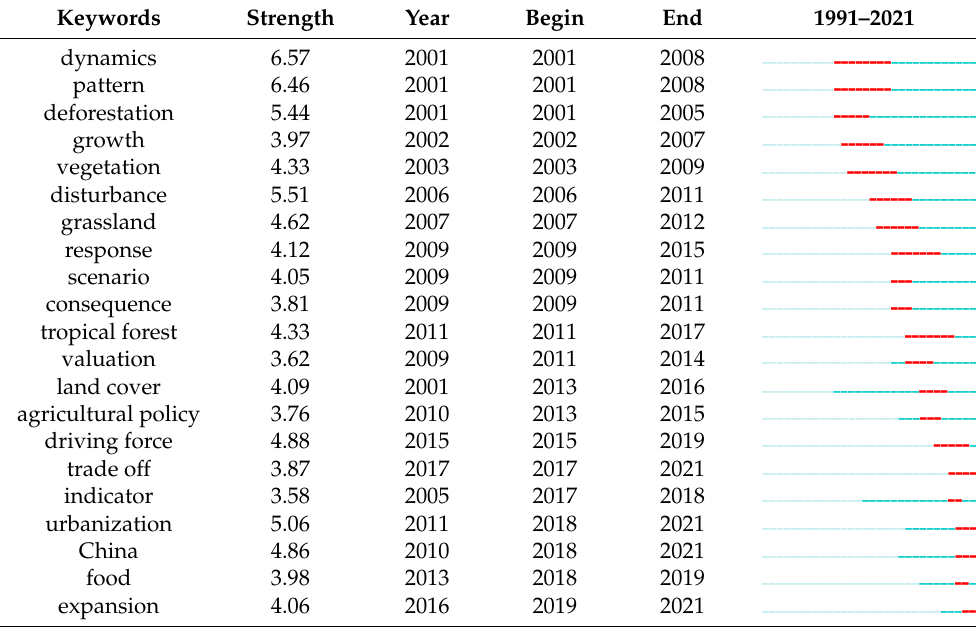
Table 5. Top 21 keywords with the strongest citation bursts.